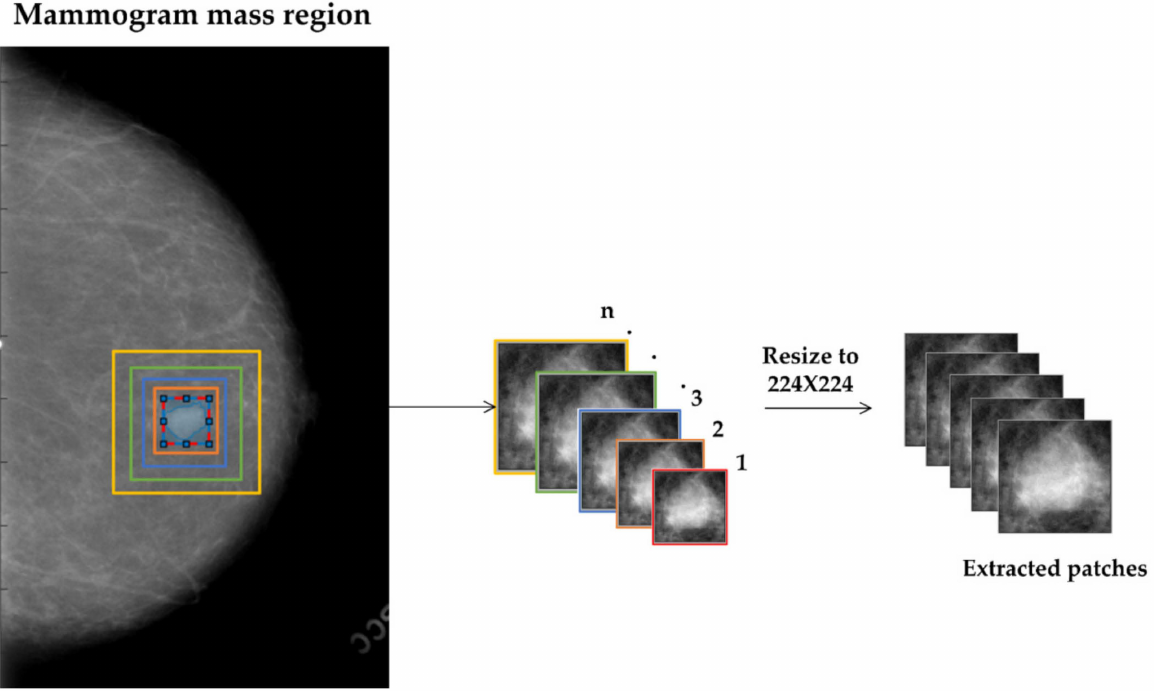
Figure 2. The regions of interest (ROIs) with different contextual information, modeled using scale-based